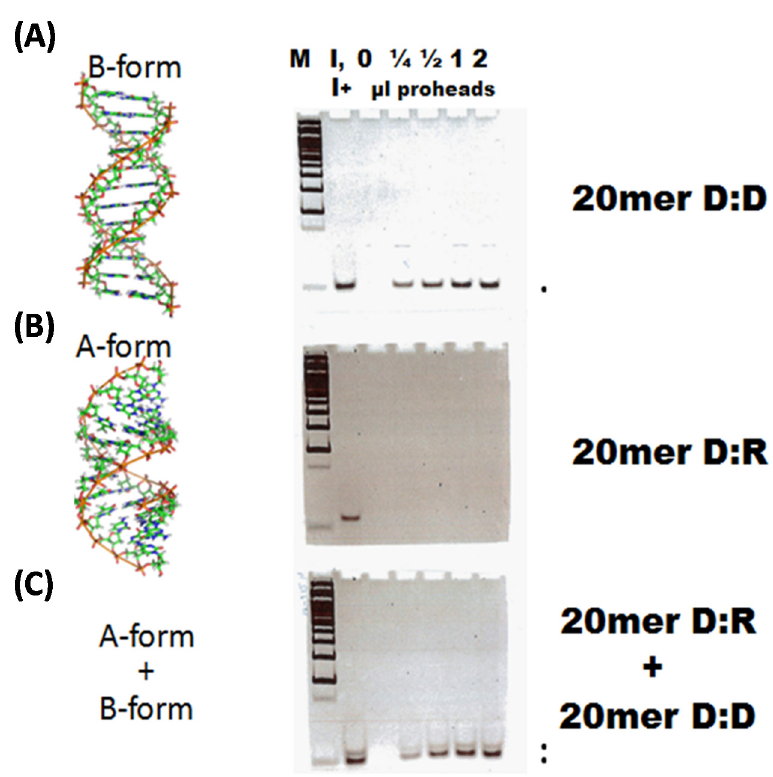
Figure 2. Nuclease assay showing packaging of ( A ) 20mer D:D, ( B ) 20mer D:R, and ( C ) 20mer D:R together with 20mer D:D substrates. Addition of a 20mer dsDNA helper (D:D) packaging substrate allows e ffi cient packaging of a 20mer DNA:RNA heteroduplex (D:R), whereas the D:R alone is ine ffi cient packaging. The D and R oligonucleotide complementary sequences are the same. Structures of B-form DNA (helix rise per base pair is ~3.4 Å) and A-form DNA (helix rise per base pair is ~2.6 Å) are shown. dsRNA and D:R heteroduplex structures are known to be A–form. M is Mol Wt marker lane, I is input packaging substrate, with µ l of proheads added to the in vitro packaging mix shown above the indicated lanes. Following nuclease digestion as described under Materials and Methods, the amount of packaging-protected ds oligonucleotide stained with EthBr is shown for each substrate or substrate mixture as indicated by the dots (.).